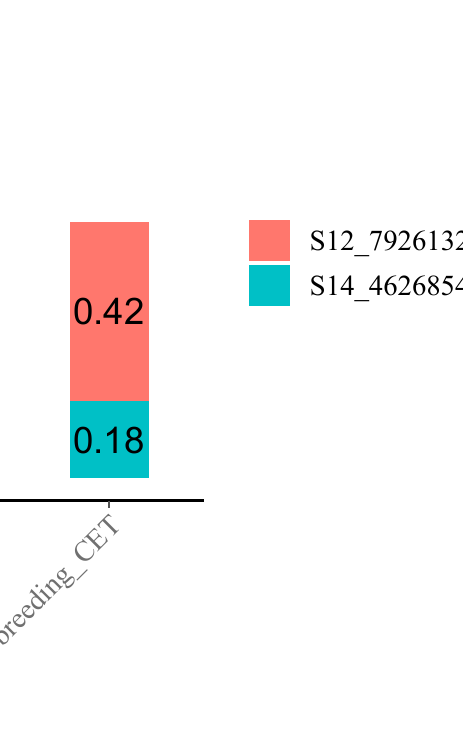
Figure 2. Frequency of favorable alleles linked to CMD resistance in the two populations.